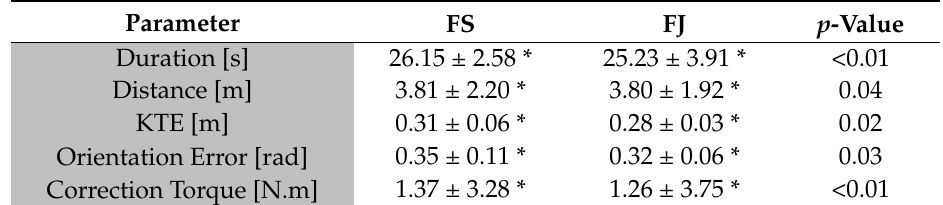
Table 3. Summary of kinematic and interaction data obtained during the trials. All parameters followed a normal distribution. Highlighted parameters (in gray) evidenced significant differences between both strategies ( p < 0.05). Asterisks indicate that the data have a normal